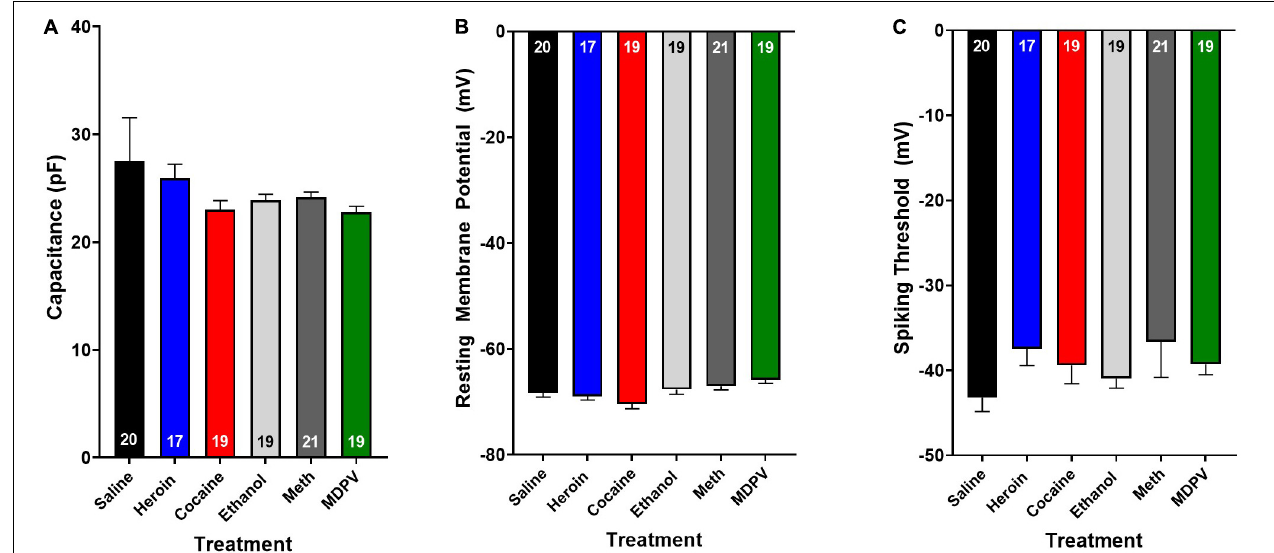
FIGURE 3 | Drug exposure does not alter basic cellular physiology. Exposure to heroin (blue), cocaine (red), ethanol (light gray), meth (dark gray), or MDPV (green) does not alter cellular capacitance (A) , resting membrane potential (B), or spiking threshold (C) of all cells recorded (grouped across type I and type II cells). Inset numbers in histograms represent the number of cells